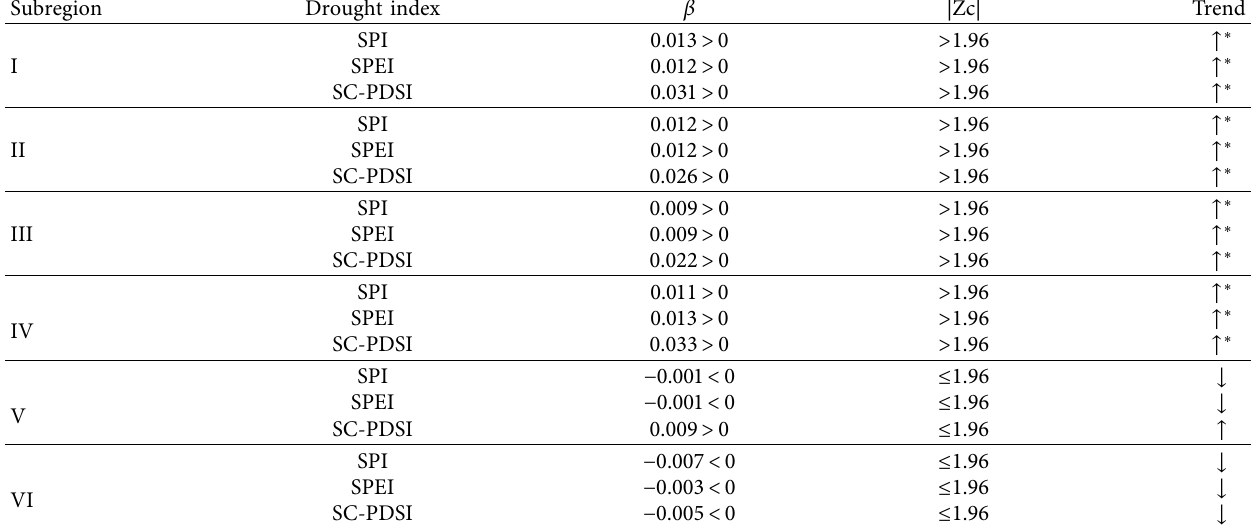
Figure 5: Spatial variations in the drought indexes in the ARNC. (a) SPI. (b) SPEI. (c) SC-PDSI. Table 4: Sen+M-K test for the changes in the SPI, SPEI, and SC-PDSI in each subregion. Subregion Drought